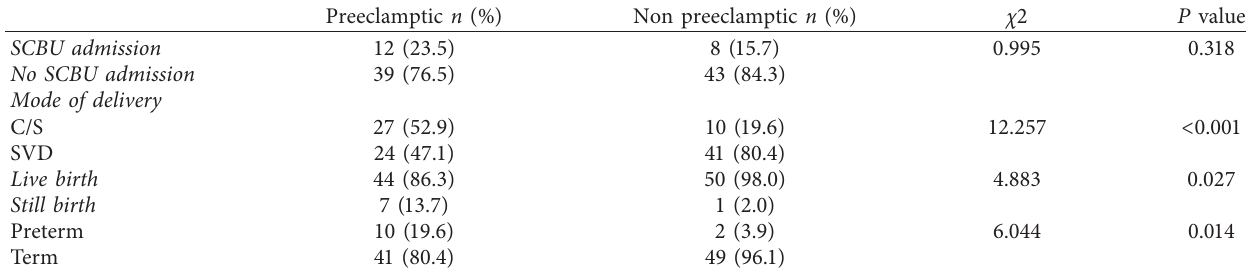
Table 3: Pregnancy outcome of the subjects.